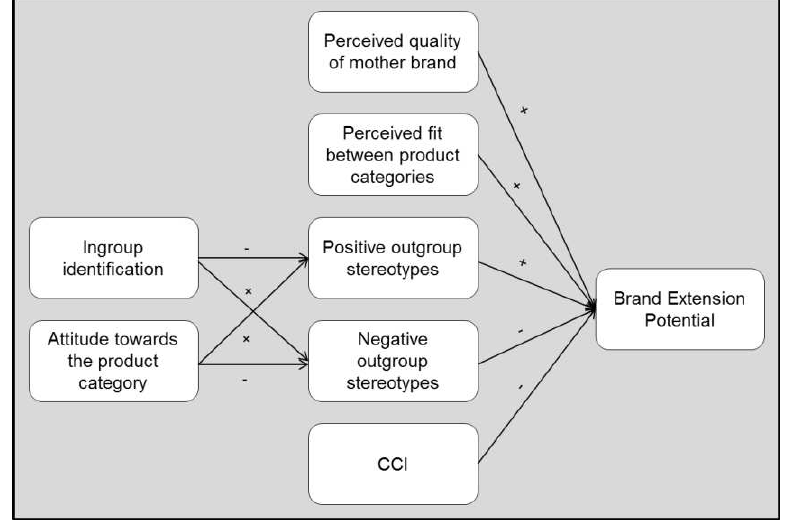
Fig. 1. Conceptual